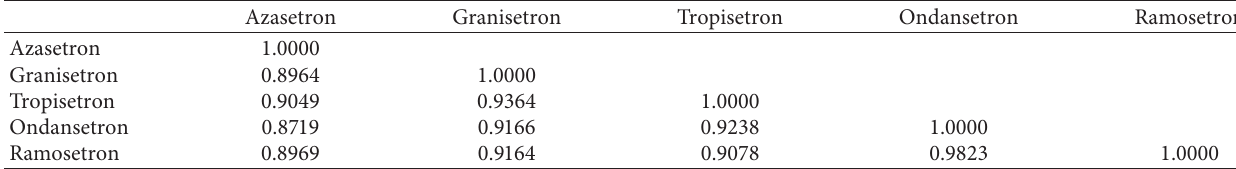
Table 3: UV spectra similarity of the five 5-HT3 receptor antagonists.